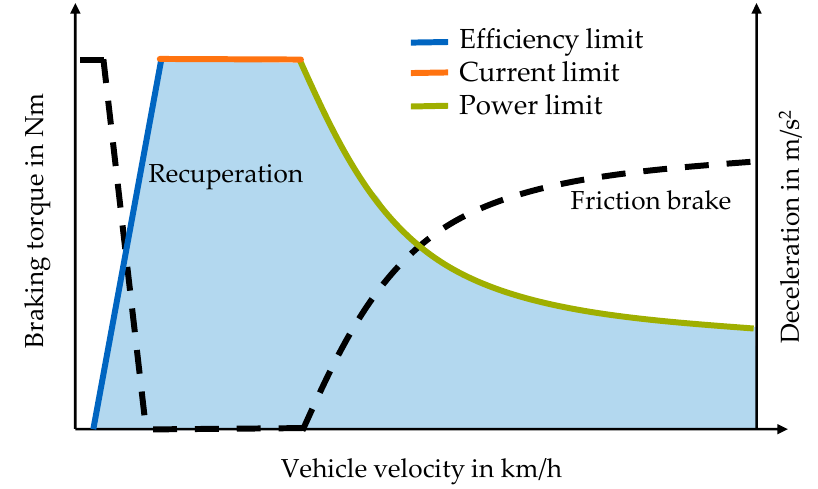
Figure 2. Distribution of the braking torque between friction brake and motor, according to reference [17] (p. 465), [19] (p. 651).